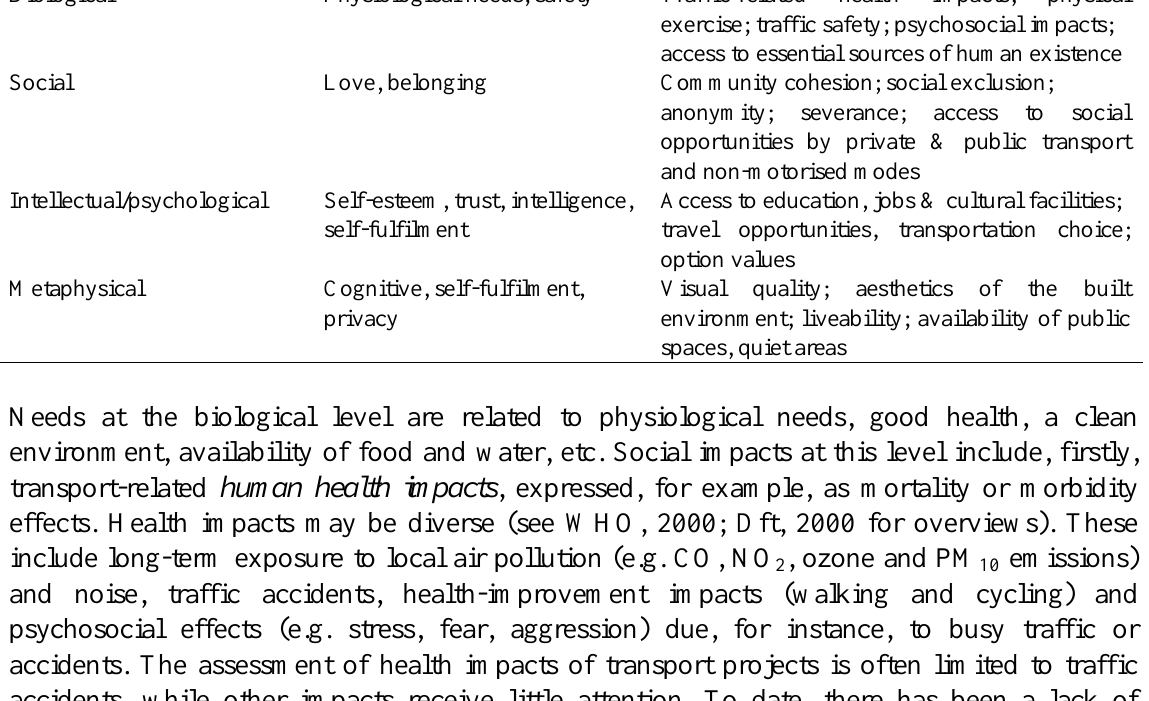
Table 1: Social impacts grouped according to four levels of human needs Level Hierarchy Impacts Biological Physiological needs,